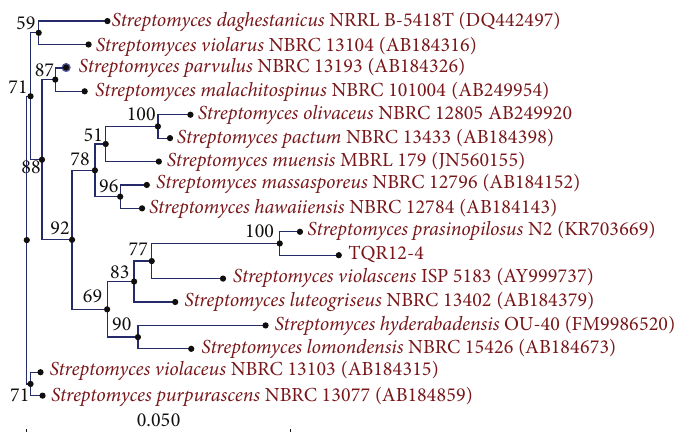
Figure 3: Neighbor-joining tree showing the phylogenetic relationships based on 16S rRNA gene sequence of the isolate TQR12-4 and closest species.